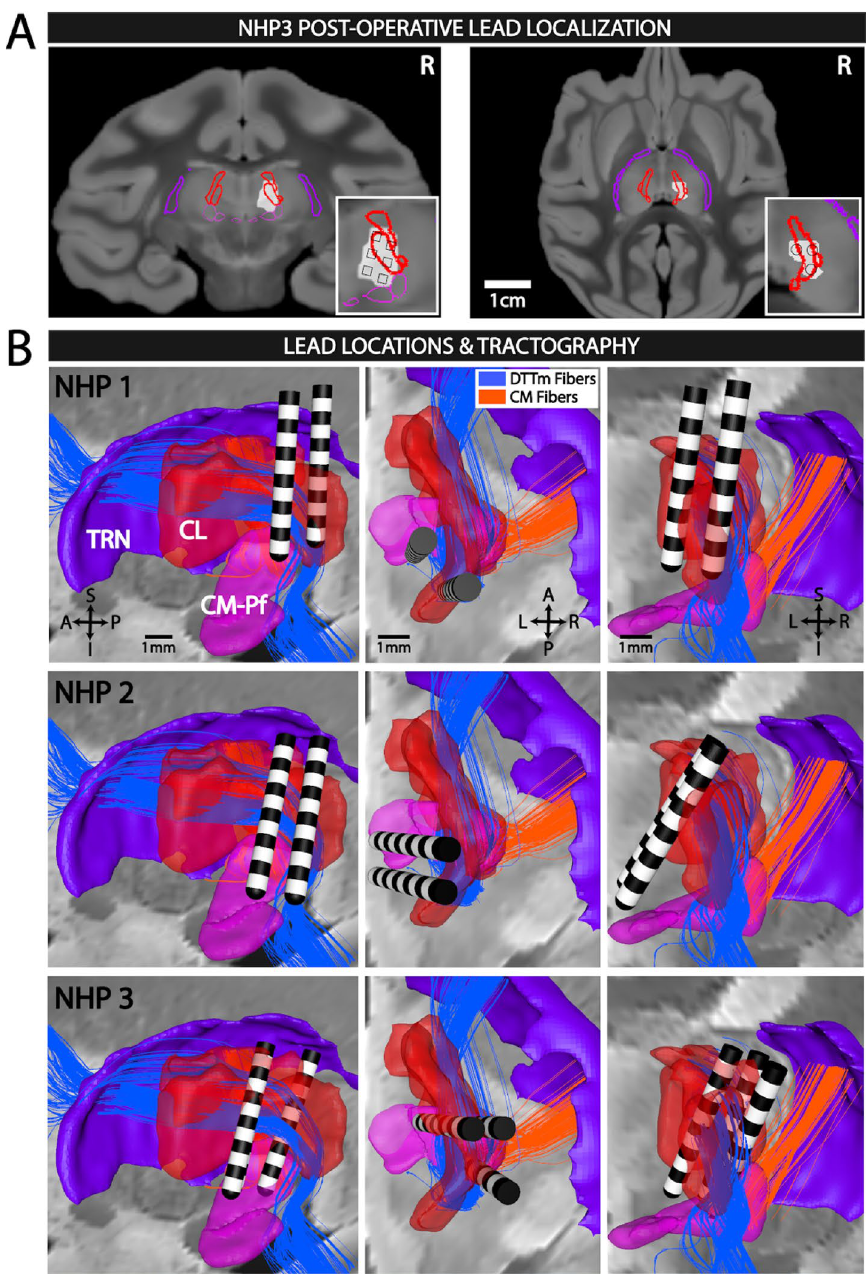
Figure 2. Central thalamic deep brain stimulation (CT-DBS) of primary ascending arousal system pathway. ( A ) Post-operative localization of the three DBS leads in the right thalamus of NHP3, with axial (left) and coronal (right) views. The computed tomography artifact of the DBS lead contacts, see insets with individual contact, is fused with the macaque MRI atlas and overlaid with segmentations of the thalamic reticular nucleus (TRN) shown in purple, the central lateral (CL) nucleus in red, and the centromedian-parafascicularus complex (Cm-Pf) in magenta. ( B ) Reconstruction of the lead locations for the three NHP subjects in the sagittal (left), axial (middle), and coronal (right) planes, along with the thalamic nuclei in A and the two predominant fiber pathways: the medial Dorsal Tegmental Tract (DTTm) shown in blue and the Cm-Pf fibers in